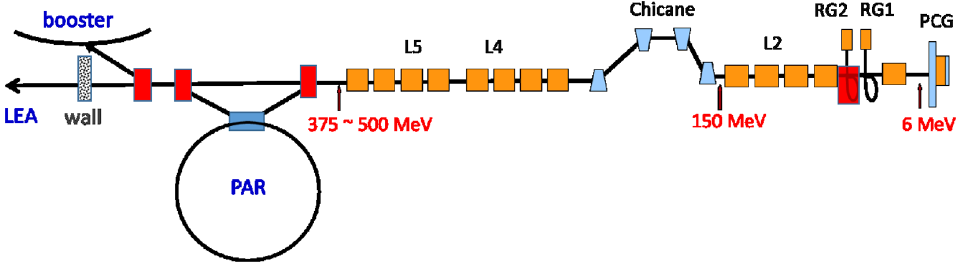
FIG. 1. Layout of APS linear accelerator.